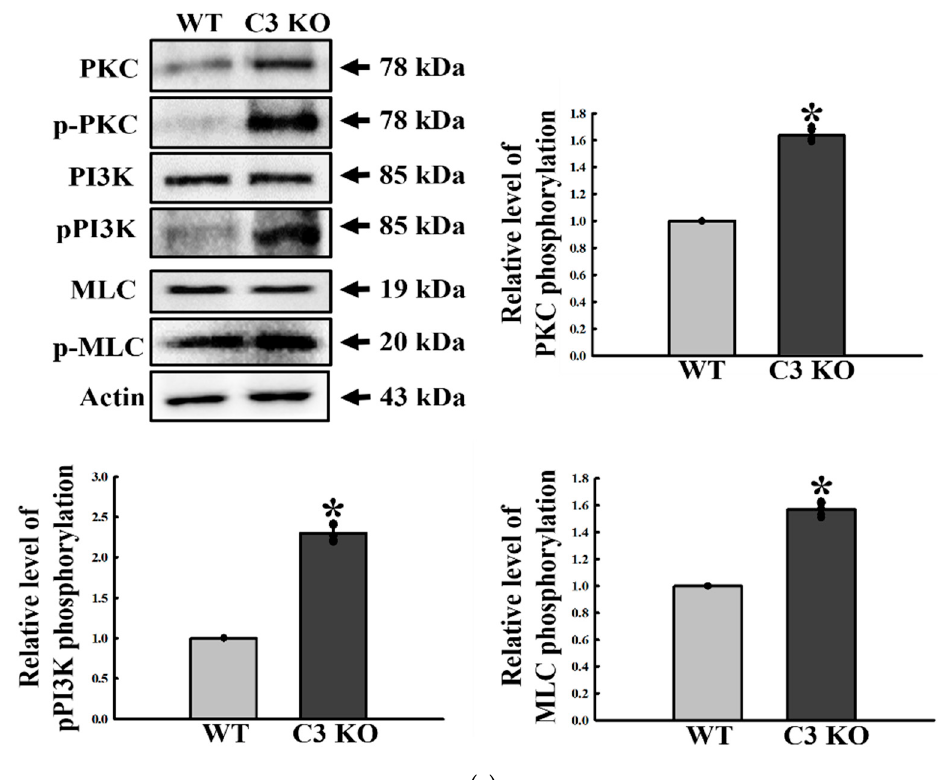
Figure 5. Expressions of mAChRs and key mediators within mAChRs downstream signaling pathway in the mid colon of C3 KO mice. ( a ) mAChR M2 and M3 expression. The expression levels of mAChR M2 and M3 were measured by Western blot analysis using the specific primary antibodies and HRP-labeled anti-rabbit IgG antibody. ( b ) G α expression. The expression levels of G α in the mAChR M2 and M3 downstream signaling pathway were measured by Western blot analysis using the specific primary antibodies and HRP-labeled anti-rabbit IgG antibody. ( c ) PKC, p-PKC, PI3K, p-PI3K, MLC, and p-MLC expression. The expression levels of six proteins in the mAChR M2 and M3 downstream signaling pathway were measured by Western blot analysis using the specific primary antibodies and HRP-labeled anti-rabbit IgG antibody. After the intensity of each band was determined using an imaging densitometer, the relative levels of the four proteins were calculated on the basis of the intensity of β -actin. Four mice per group were used to prepare the total tissue homogenate, and Western blot analyses were assayed in duplicate. Data are reported as the mean ± SD. * p < 0.05 compared to the WT group. Abbreviations: WT, wildtype; KO, knockout; mAChR, muscarinic acetylcholine receptors; G α , G-protein alpha subunit; PKC, protein kinase C; PI3K, phosphoinositide 3-kinase; MLC, myosin light chain; HRP, horseradish peroxidase; IgG, immunoglobulin G.